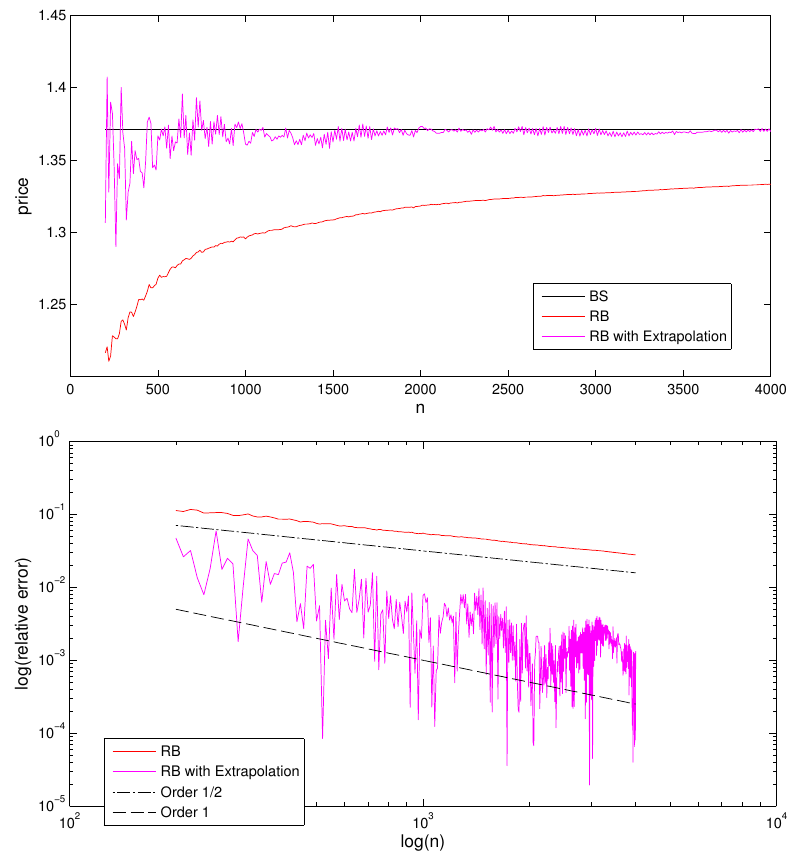
Figure 7. RB with extrapolation: up-and-in barrier put with T = 1, r = 0.1, σ = 0.25, s 0 = 100, K = 110, B = 120.